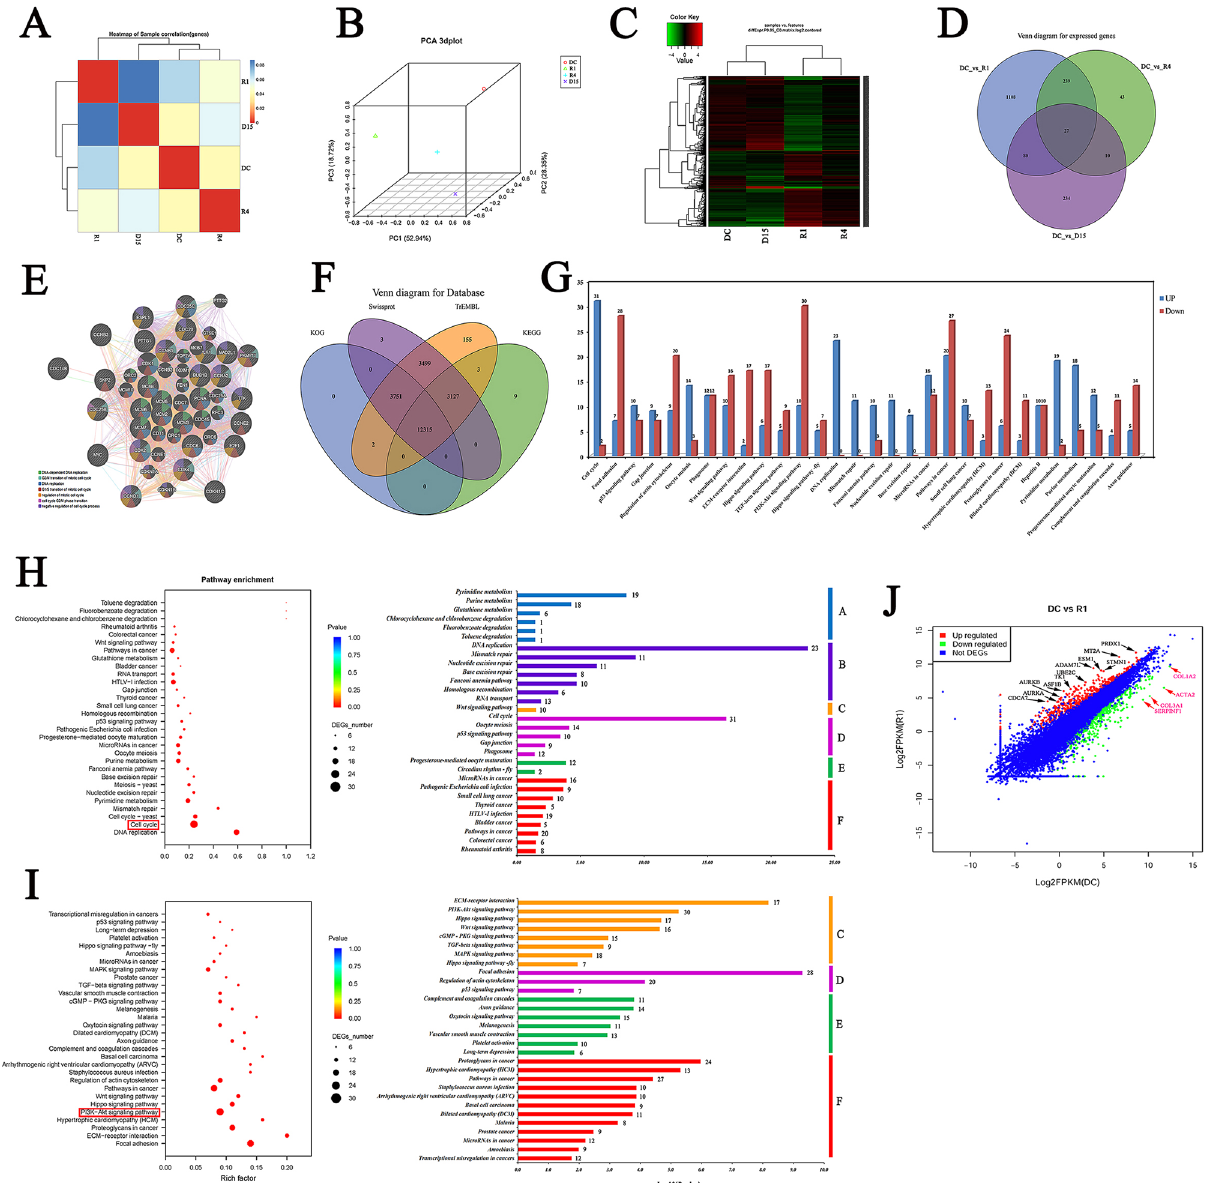
Figure 8. Enriched pathways consisting of DEGs among 4 libraries using RNA-sequencing. ( A ) Heatmap of 4 groups correlation; ( B ) Principal component analysis of 4 samples. ( C ) Heatmap for all DEGs. ( D ) Venn diagram for expressed genes; ( E ) IPA analysis of 27 DEGs found among four groups. ( F ) Venn diagram for 4 databases. ( G ) Top thirty enriched pathways consisting of DEGs between C1 and R1. ( H ) 30 enriched pathways consisting of up-regulated genes were further classified into six categories. ( I ) 30 enriched pathways consisting of down-regulated genes were further classified into four categories. ( J ) Digital expression level of DEGs between C1 and R1. Red points indicate up-regulated DEGs and green points indicate down-regulated